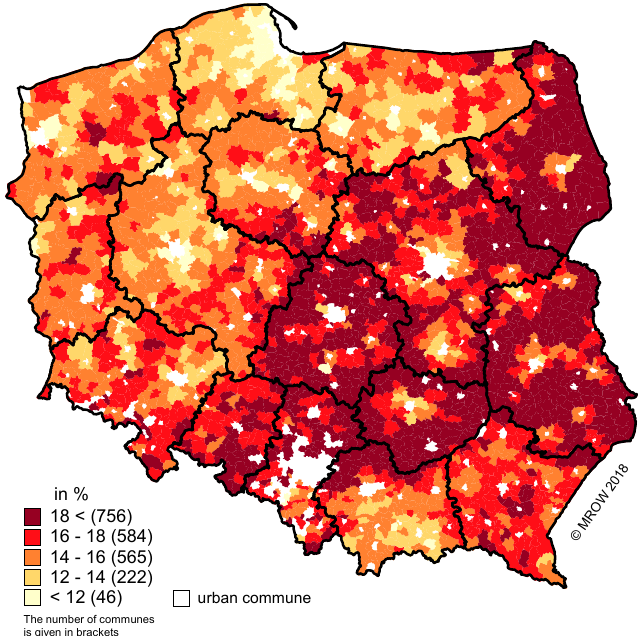
Figure 2. Proportion of rural residents at retirement age in the total commune population. Source: [20] (p. 116).